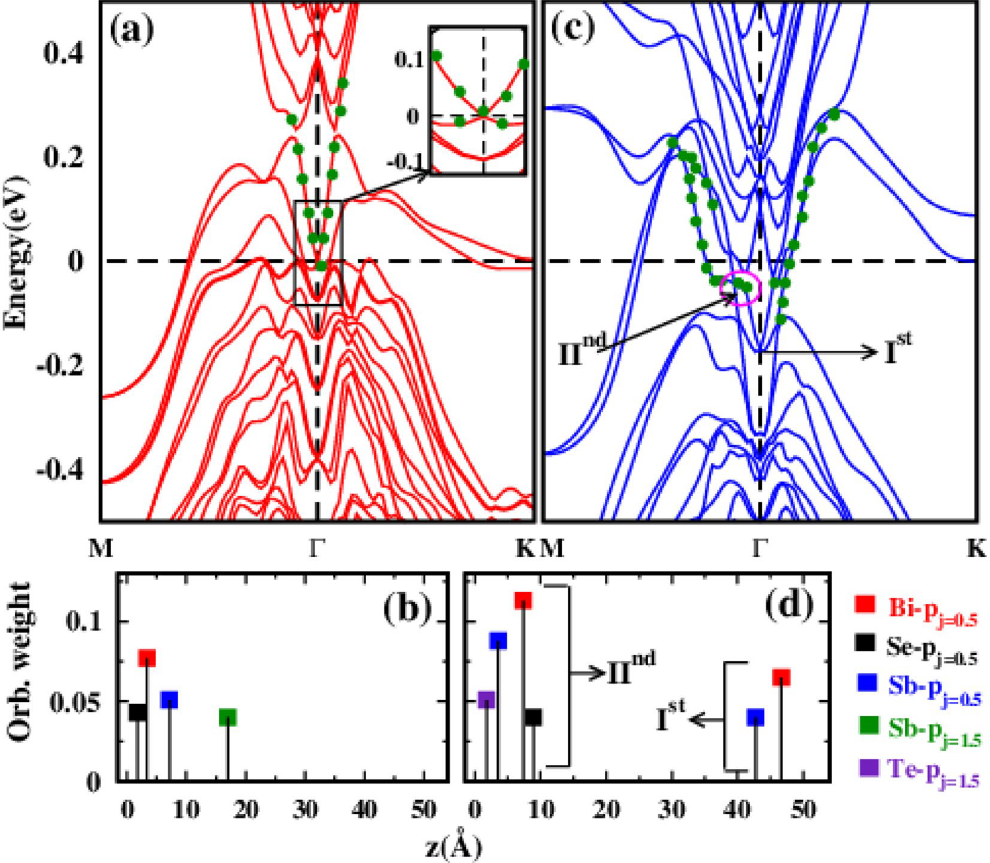
Figure 4. ( a and c ) show calculated bands of Se1 and Te terminated face of 6QL slab geometry of BiSbTeSe 2 respectively. ( b ) Weight of atomic orbitals mainly contributing to the ‘V’ shaped band (enclosed in the black box) at the Γ point in Se terminated plain with respect to their distances from the surface. ( d ) Similar contribution to V shaped band at the Γ point (I st ) and slightly away from the Γ point (II nd ) in Te terminated